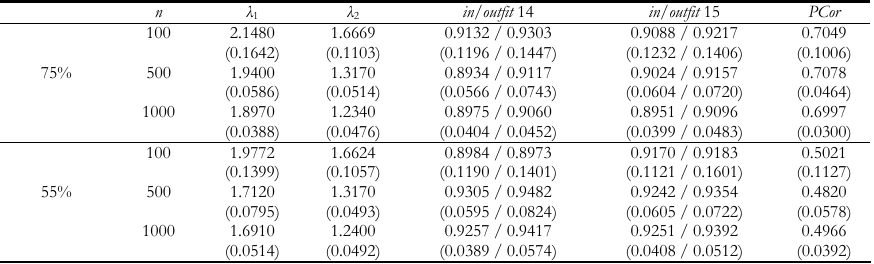
Mean value, calculated on 100 simulated data sets, of the first two eigenvalues, the infit and outfit mean square statistics of items 14 and 15 and the Pearson correlation for the couple 14-15; in parenthesis the standard errors n λ